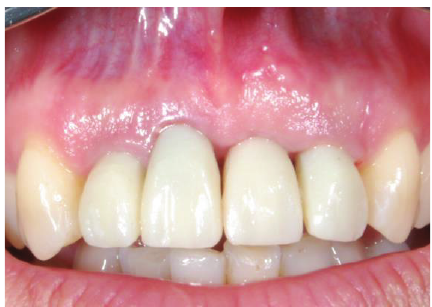
Figure 10: The immediate temporary nonfunctional bridge after seating and adjustment.